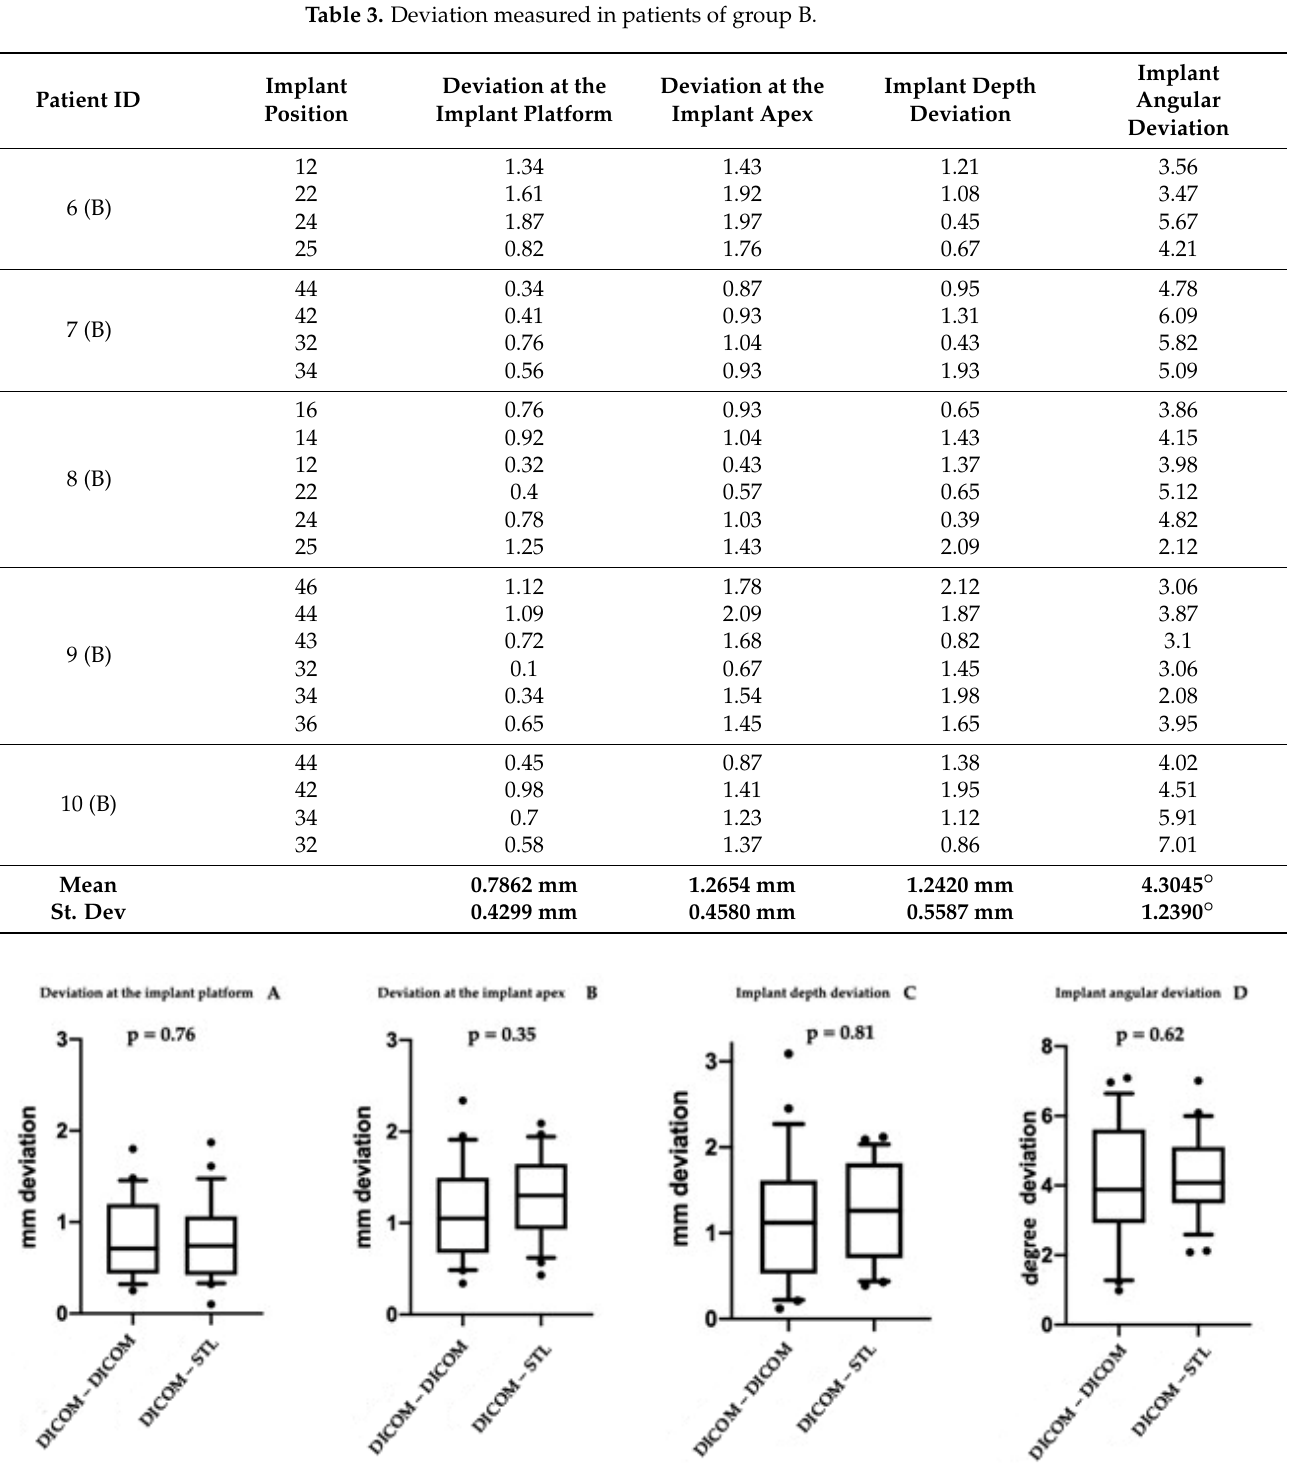
Figure 4. Images of the statistical comparisons between the two groups. The different positional and angular deviations analyzed did not show statistically significant differences.